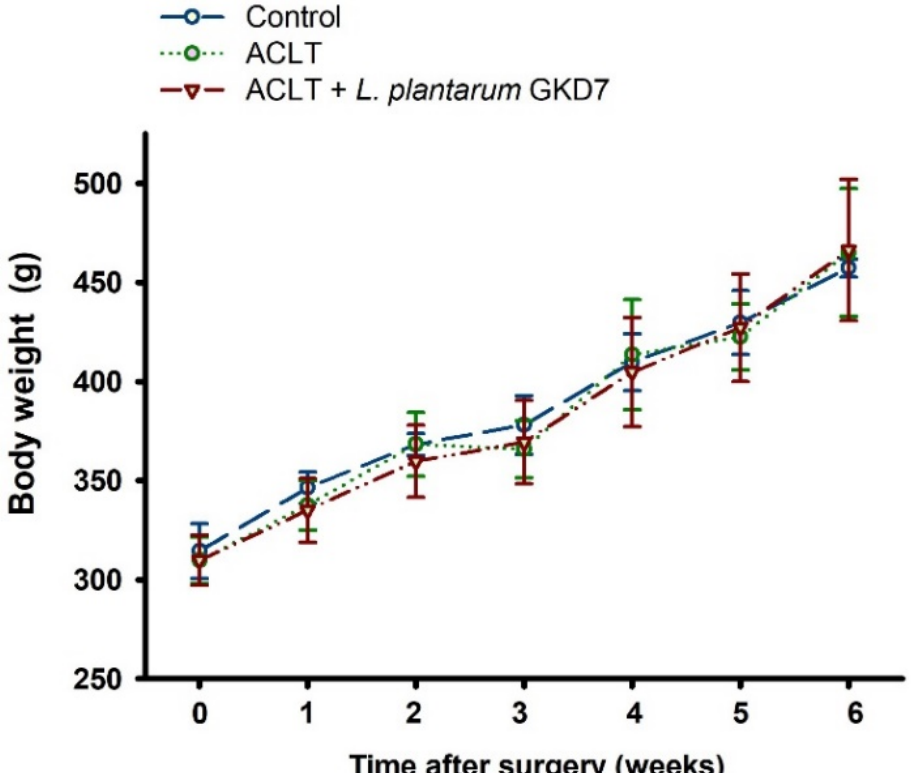
Figure 1. Oral live L. plantarum GKD7 did not affect body weight in the OA rat model. Body weights of ACLT rats that did or did not receive oral live administration of live L. plantarum GKD7 were not significantly different from those of